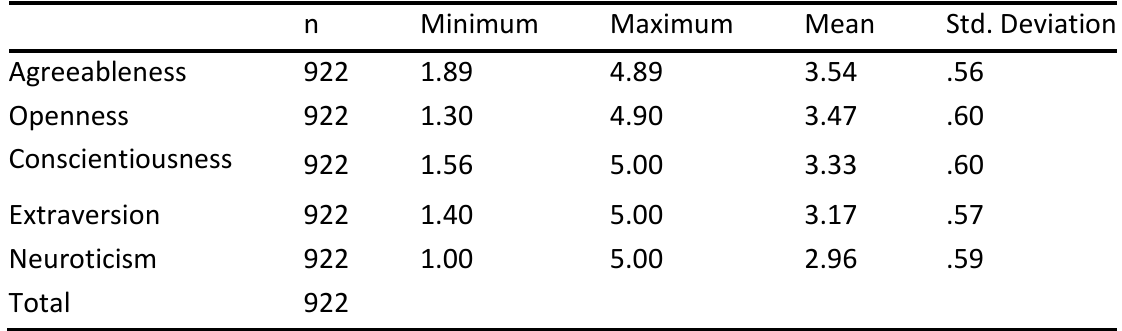
Table 2. Descriptive Statistics of Personality Traits of ELL Department